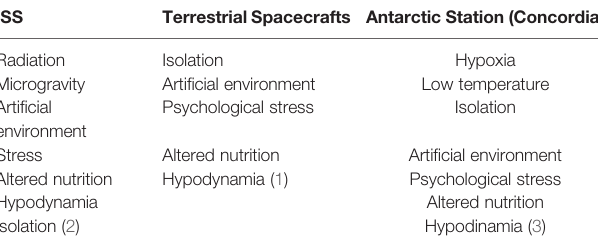
TABLE 1 | Isolation facilities